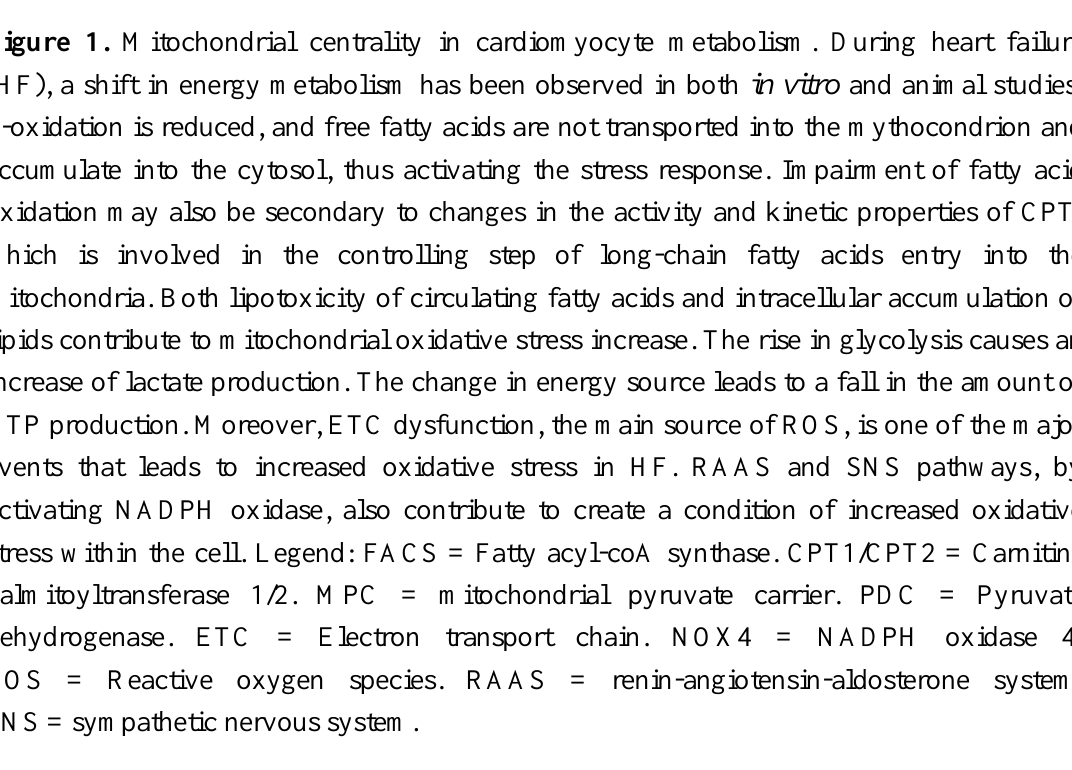
Figure 1. Mitochondrial centrality in cardiomyocyte metabolism. During heart failure (HF), a shift in energy metabolism has been observed in both in vitro and animal studies.